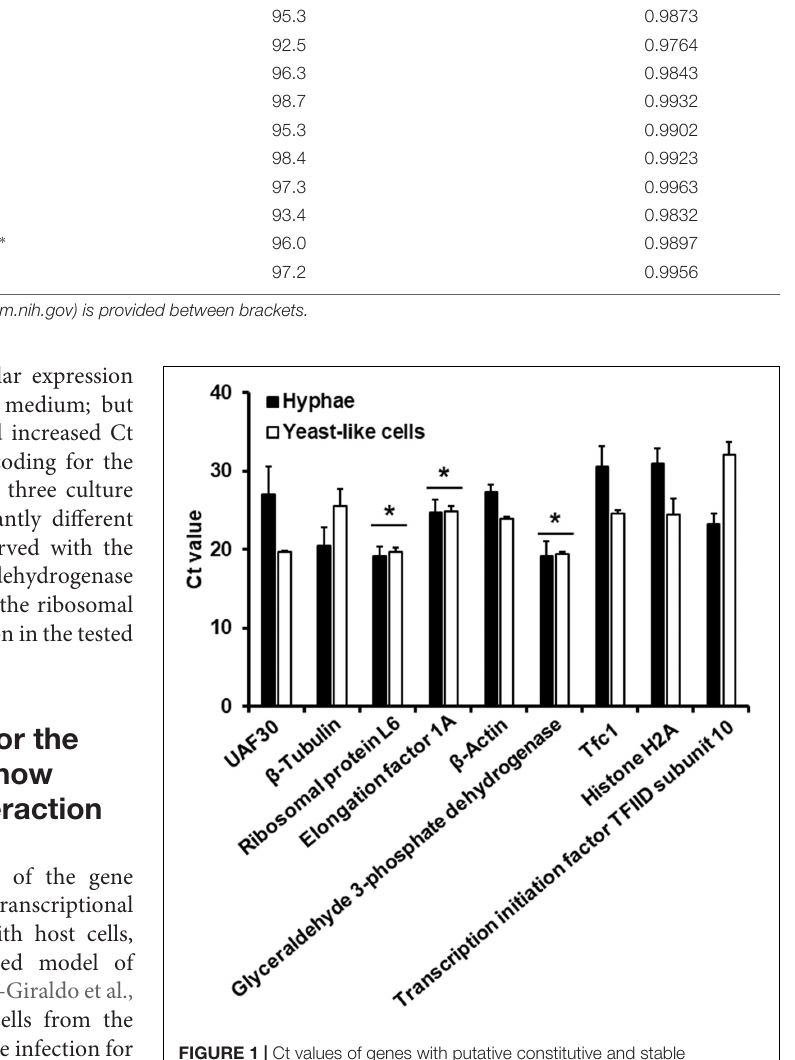
FIGURE 1 | Ct values of genes with putative constitutive and stable expression in both Sporothrix schenckii sensu stricto hyphae and yeast-like cells. Cells were grown in YPD medium under controlled conditions to generated either hypha (closed bars) or yeast-like cells (open bars) (see Materials and Methods). Total RNA was extracted, cDNA synthesized with oligo(dT) primer (20 mer) and the gene expression was quantified by RT-qPCR using specific primers (see Table 1 ). Only the genes encoding the ribosomal protein L6, elongation factor 1A, and glyceraldehyde 3-phosphate dehydrogenase showed constant expression in both morphologies ( ∗ P >